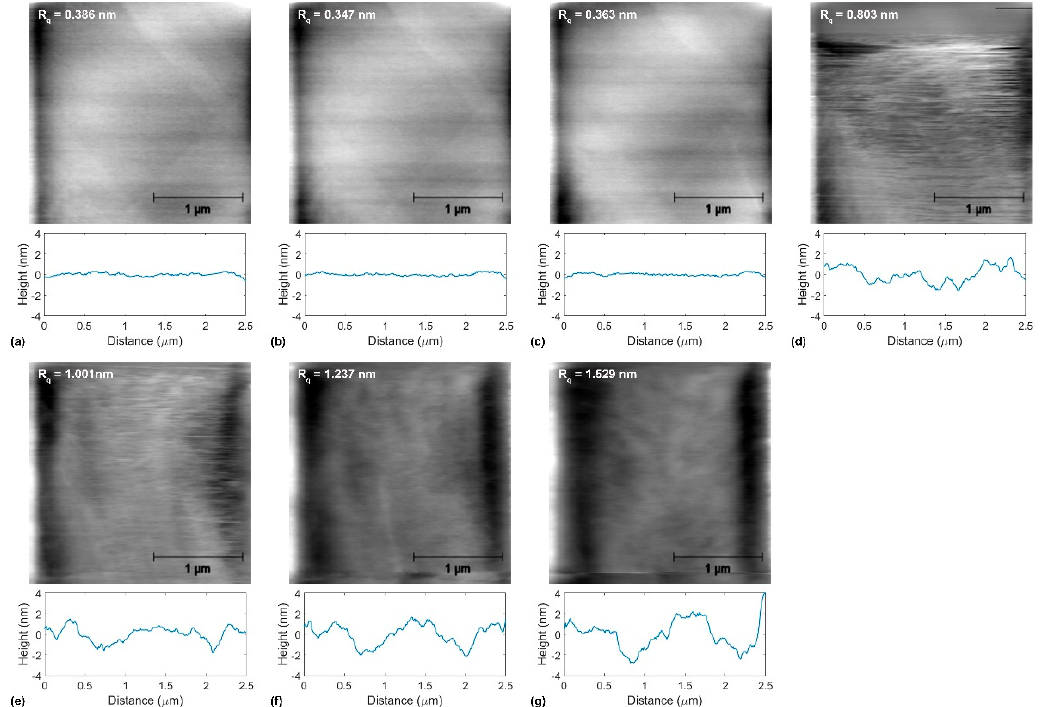
Figure 4. Topographical evolution during tribological tests of annealed copper at the normal force values ( a ) F n = 153 nN, ( b ) F n = 616 nN, ( c ) F n = 1232 nN, ( d ) F n = 2310 nN, ( e ) F n = 3850 nN, ( f ) F n = 5390 nN, and ( g ) F n = 6930 nN. In ( a – g ), the atomic force microscopy (AFM) topographical images at the normal force values indicated above, the corresponding roughness parameter R q -values, and representative line scans are presented.